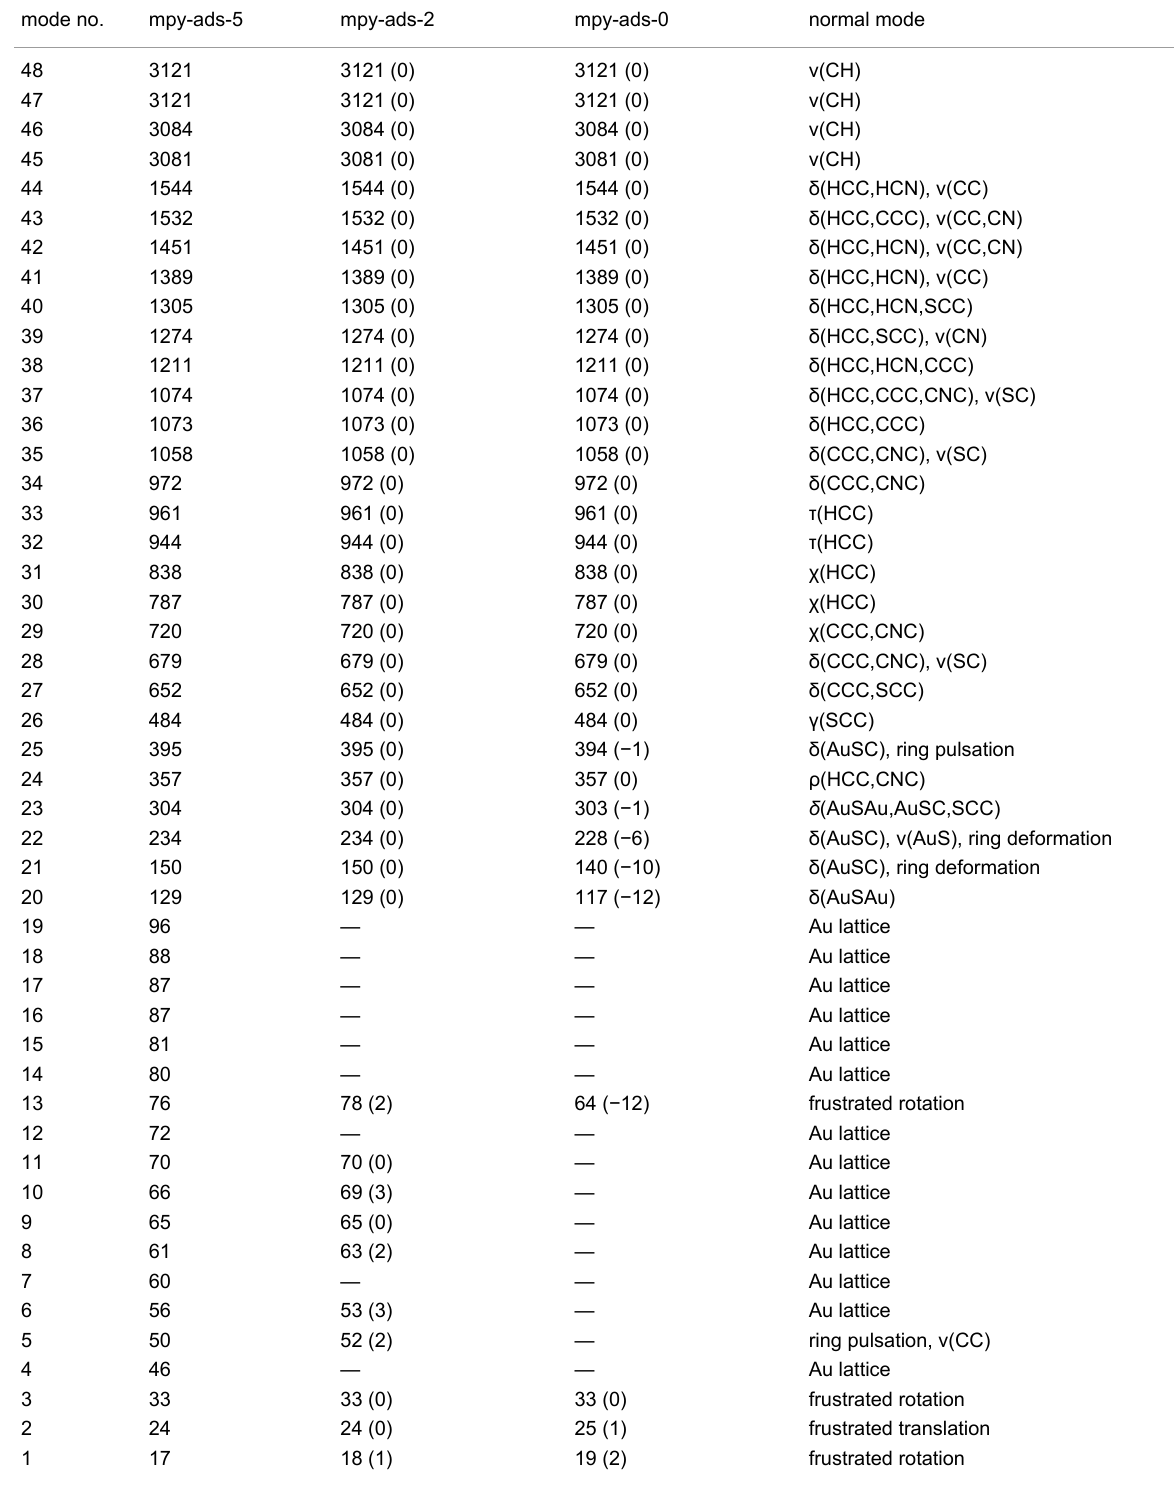
Table 2: Harmonic frequencies for mpy-ads-5, mpy-ads-2 and mpy-ads-0 (PBE/PAW); in parentheses deviation of mpy-ads-2 and mpy-ads-0 with respect to mpy-ads-5; in cm − 1 . Mode numbers from mpy-ads-5. Assignment of normal mode vibrations: ν – stretching, δ – in-plane bending, γ – out- of-plane bending, ρ – rocking, χ – wagging, τ –